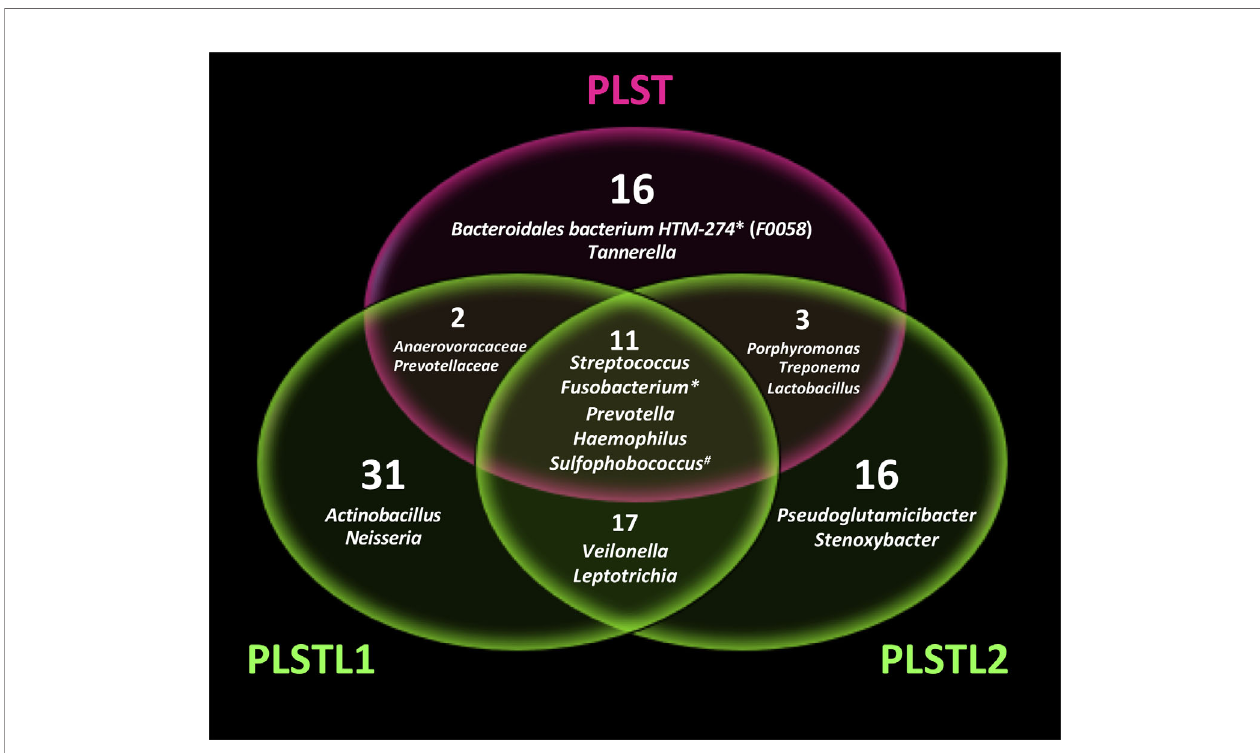
FIGURE 5 | Venn diagram showing the shared microbial genus in Papillon – Lefèvre syndrome toothed patient (PLST) and toothless (PLSTL1 and PLSTL2) sisters. Asterisk indicates high abundance in PLST sister (>20%). Number symbol indicates the highest abundance of Archaea domain in